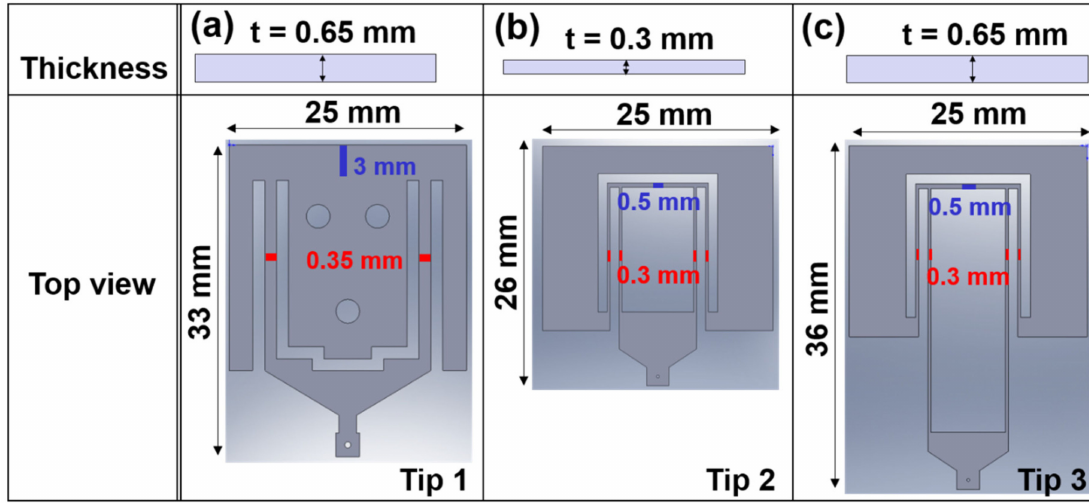
Figure 7. Schematic designs of the cantilever tips with di ff erent shapes and sizes. ( a ) Tip 1; ( b ) Tip 2; ( c ) Tip 3. Top: Thickness, Bottom: Top